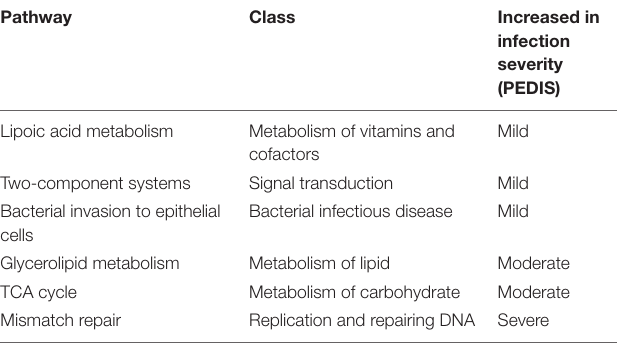
TABLE 2 | Pathways significantly changed between infection severities ( P < 0.05).